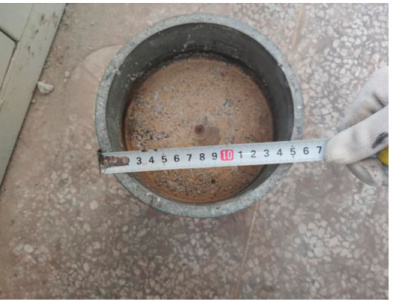
Figure 5. Crushed stone mixture specimen after